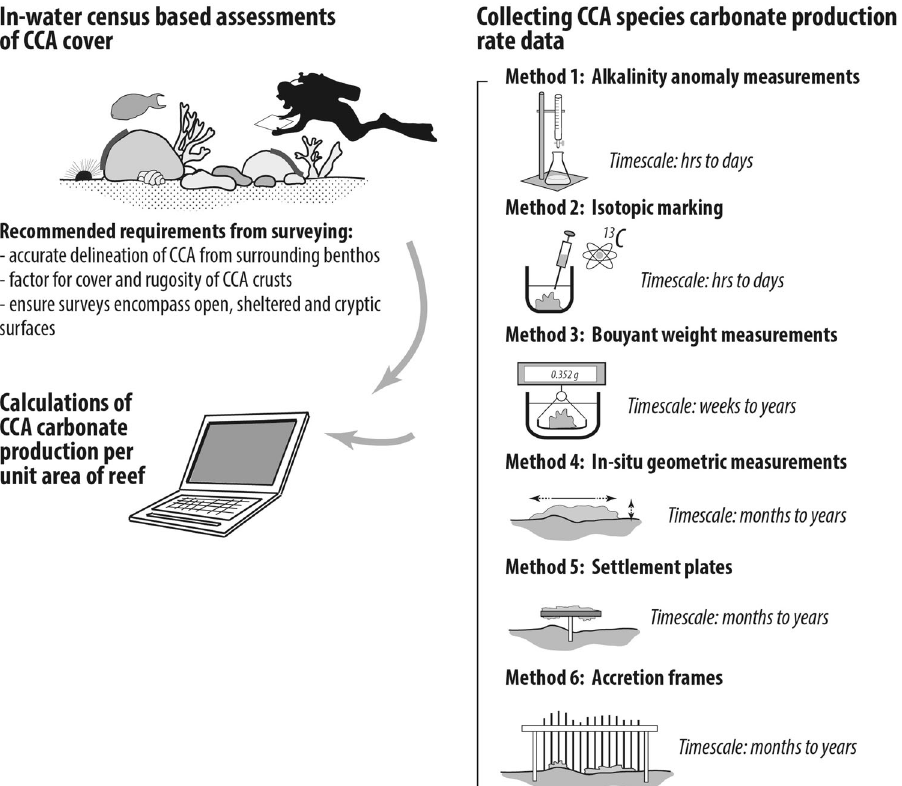
Fig. 6 Methods to measure CCA contribution to carbonate budgets. This includes two steps: (1) in-water census-based assessments of CCA cover and rugosity; (2) measurements of species-speci fi c calci fi cation or carbonate production through total alkalinity anomaly technique, isotope labelling, buoyant weight measurements over time, in situ geometric measurements, settlement plates, or accretion